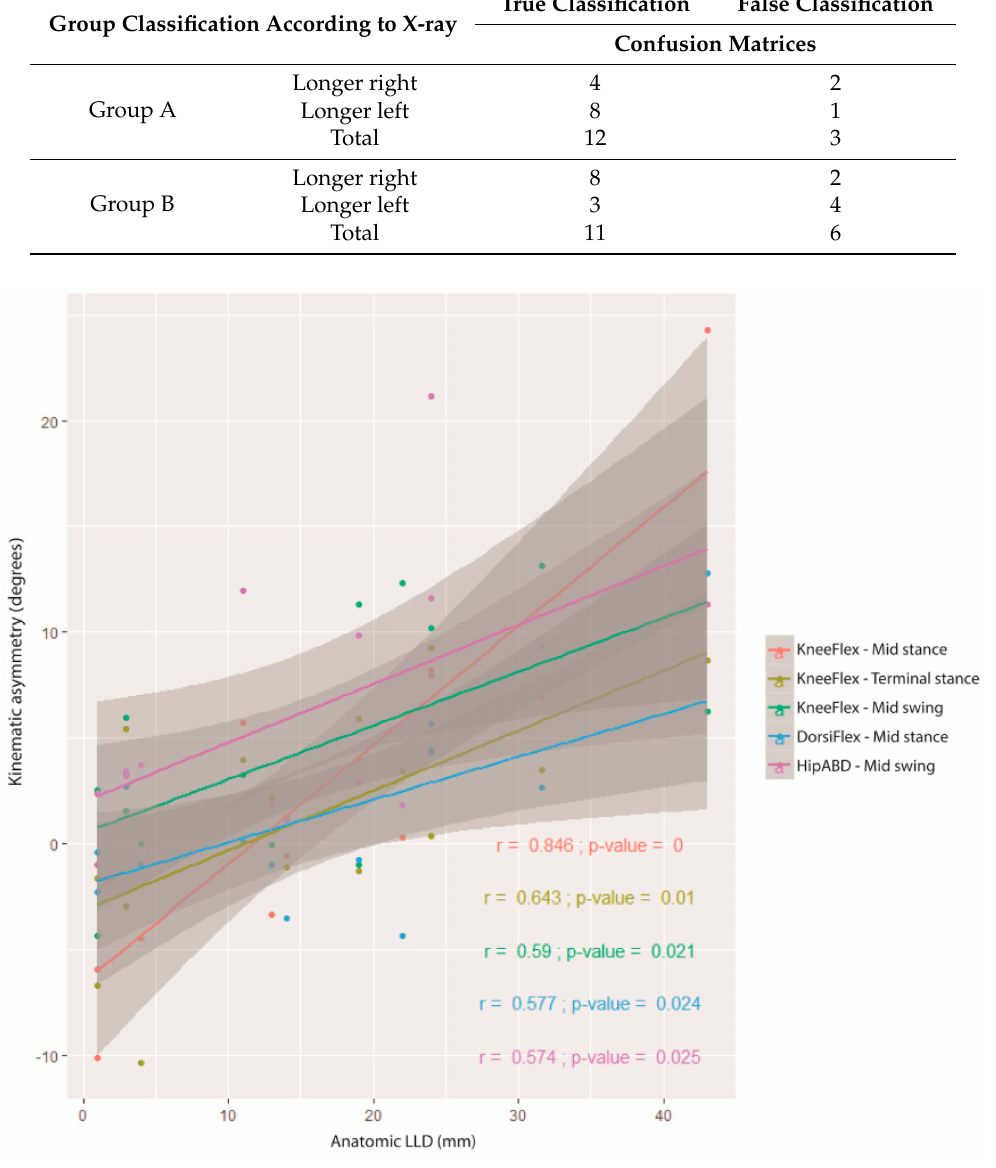
Figure 3. The correlations between kinematic asymmetry and anatomic LLD (with a 95% confidence interval of the regression